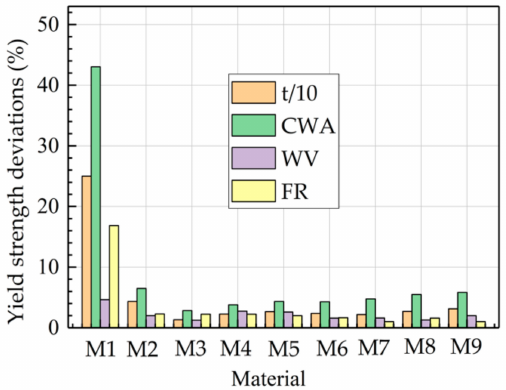
Figure 13. Deviation results of yield load identified by di ff erent